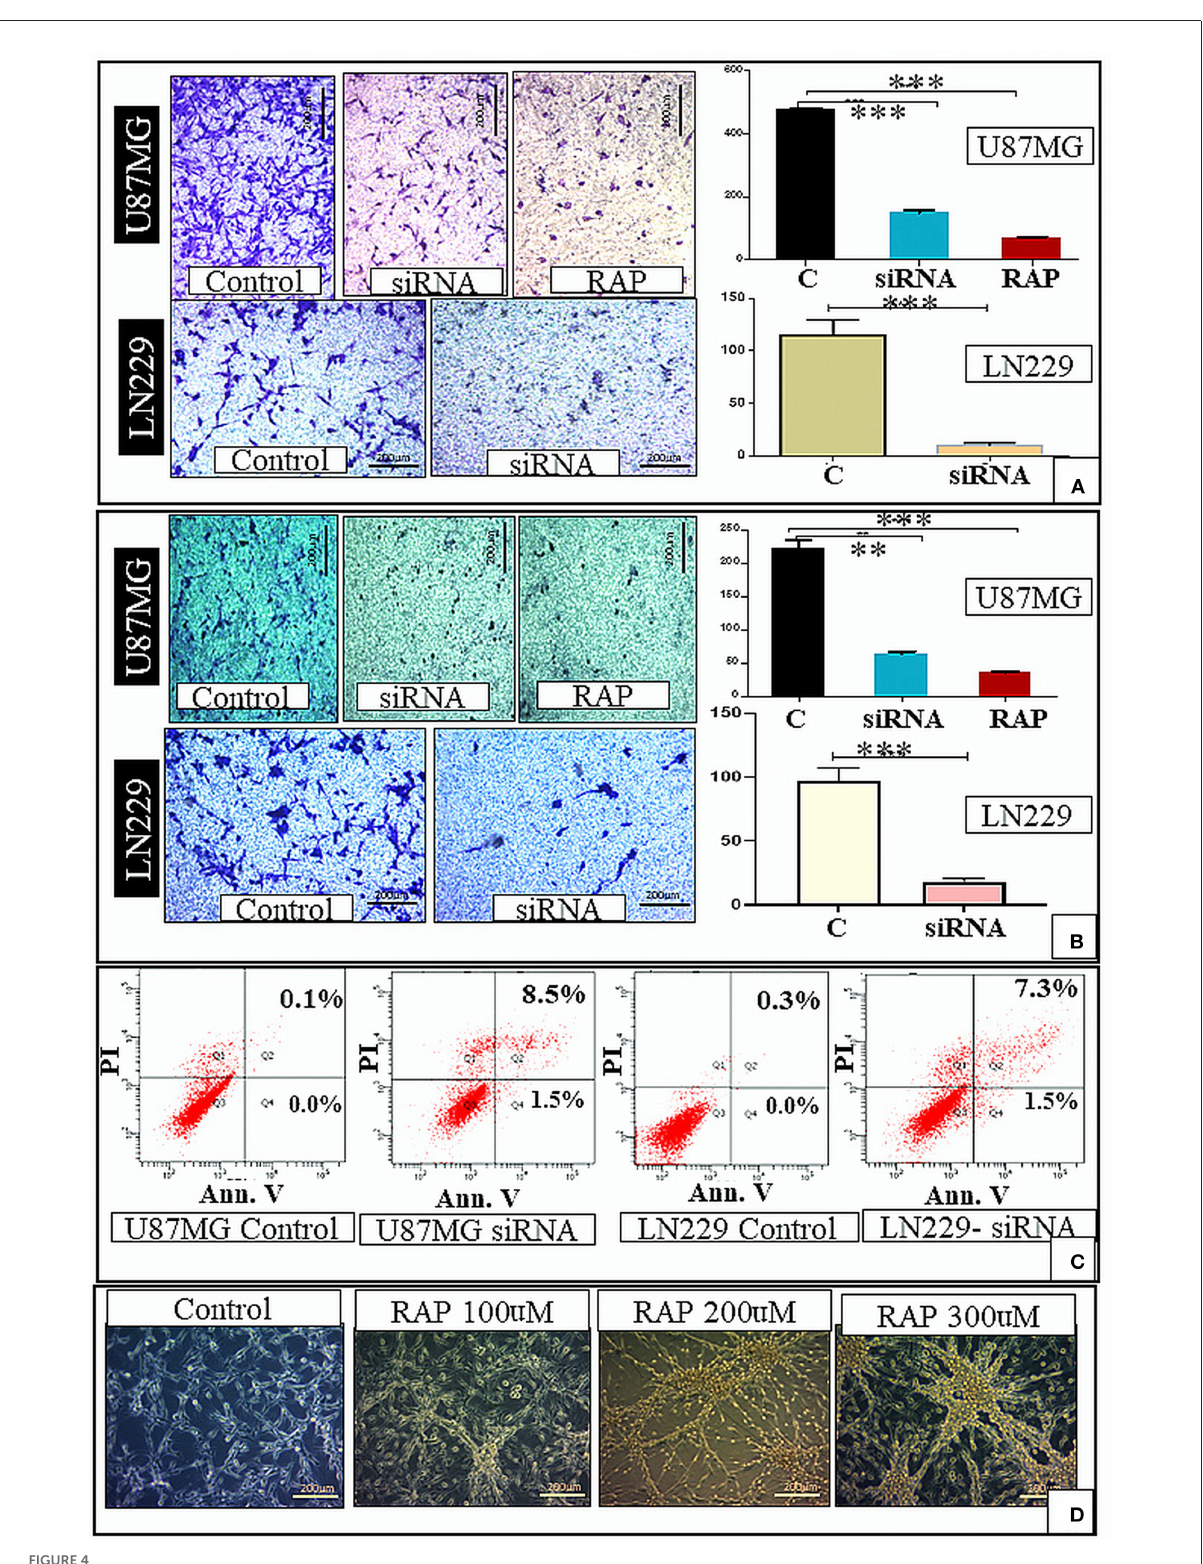
FIGURE4 In-vitro study. There was decrease in the cell migration after gene knockdown and RAP treatment as compared to the control (A) . There was also decrease in the cell invasion after gene knockdown and RAP treatment as compared to the control (B) . There was increase in the